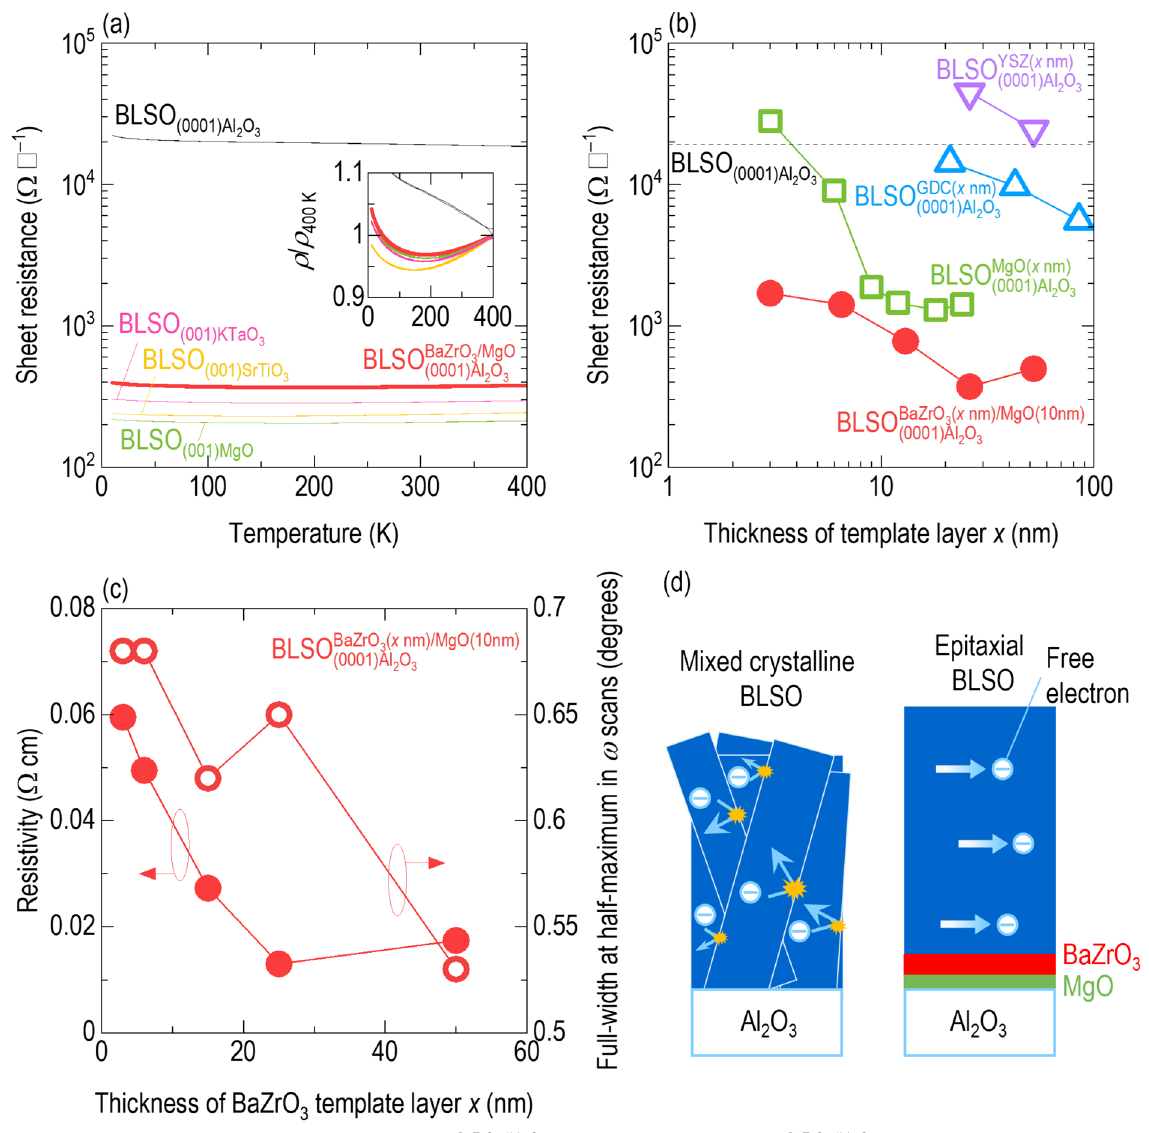
Fig. 3 Single-crystalline-level conductive property of BLSO BaZrO 3 / MgO ( 0001 ) Al . a The sheet resistance of BLSO BaZrO 3 / MgO ( 0001 ) Al is ~ 50 times lower than that of 2 O 3 2 O 3 BLSO ( 0001 ) Al and is comparable to those of single-crystalline BLSO epitaxial films grown on KTaO 3 , SrTiO 3 , and MgO. The inset shows that the 2 O 3 resistivities ρ , normalized by the 400 K resistivity ρ 400 K , of BLSO BaZrO 3 / MgO ( 0001 ) Al , BLSO ( 001 ) KTaO 3 , BLSO ( 001 ) SrTiO , and BLSO ( 001 ) MgO increase above 150 K, 3 2 O 3 indicating metallicity near room temperature. b The sheet resistances of BLSO BaZrO 3 / MgO ( 0001 ) Al and BLSO MgO ( 0001 ) Al decrease with increasing template 2 O 3 2 O 3 layer thickness and are saturated above 10–20-nm-thick template layers. The dashed line indicates the sheet resistance of BLSO ( 0001 ) Al . c The 2 O 3 lower resistivity of BLSO BaZrO 3 / MgO ( 0001 ) Al with a thicker BaZrO 3 template layer is attributed to enhanced crystallinity, as evidenced by a smaller full-width at 2 O 3 half-maximum. d Compared with BLSO ( 0001 ) Al , there are fewer scattering centres for free electrons in BLSO BaZrO 3 / MgO ( 0001 ) Al 2 O 3 2 O